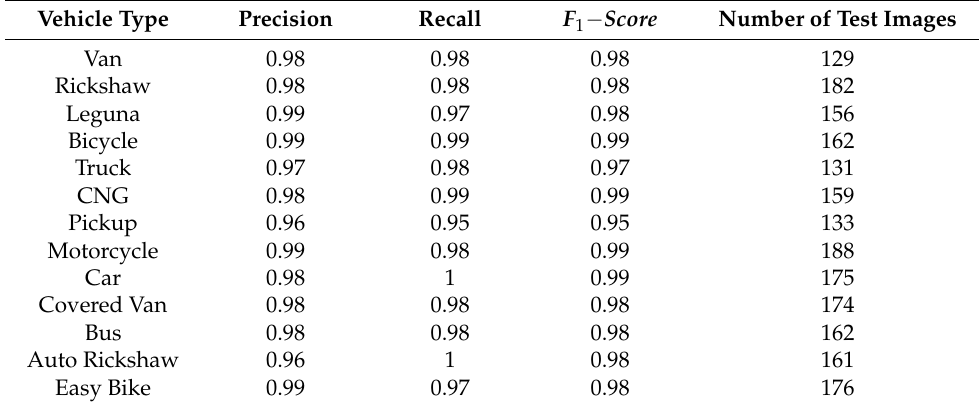
Table 3. The classification report for our proposed ResNet-50 pre-trained model.